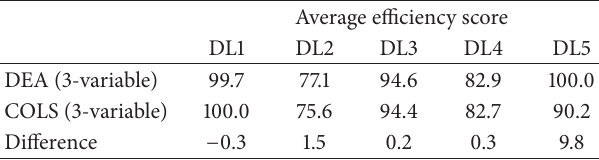
Table 12: Average efficiency scores. Table 13: Ranking of